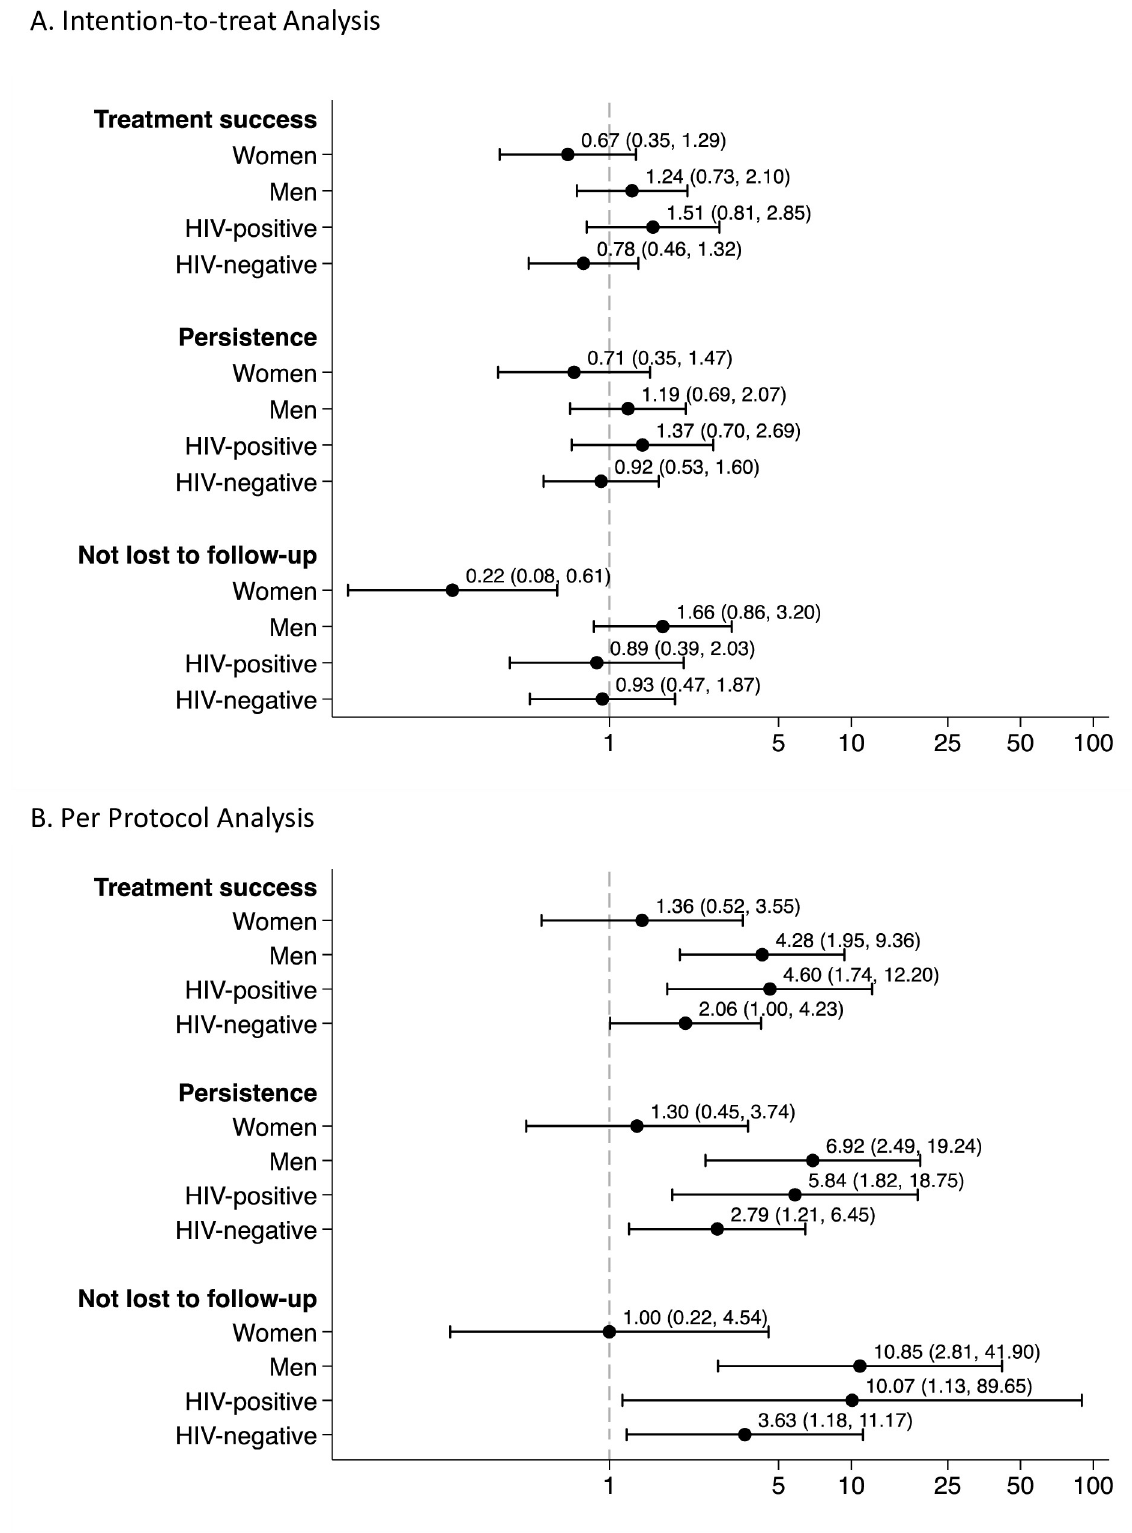
Fig 3. Effectiveness of 99DOTS among subgroups. The data shown are odds ratios (ORs) from mixed effects logistic regression models for the (A) intention-to-treat analysis and (B) per protocol analysis. All models are adjusted for time (month), disease class (bacteriologically